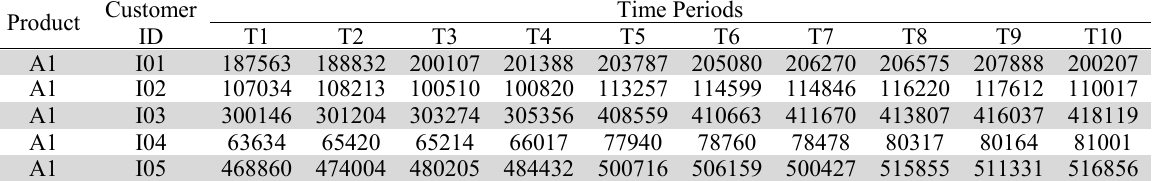
Demand of each customer for product A 1 over time periods Customer Product